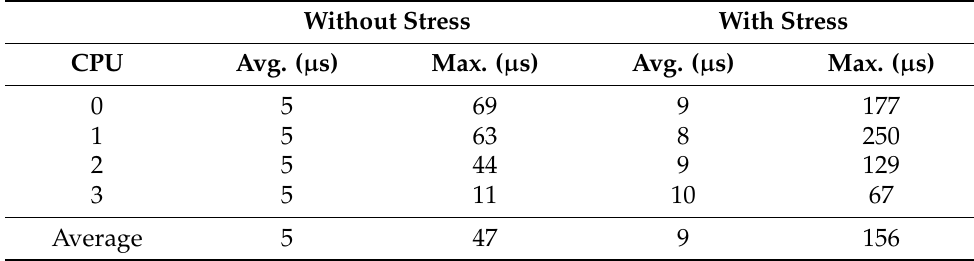
Figure 3. Average thread latency in each CPU and vCPU in Linux and Xen DomU with stress and without stress. Table 1. Linux thread latency in Linux (Figure